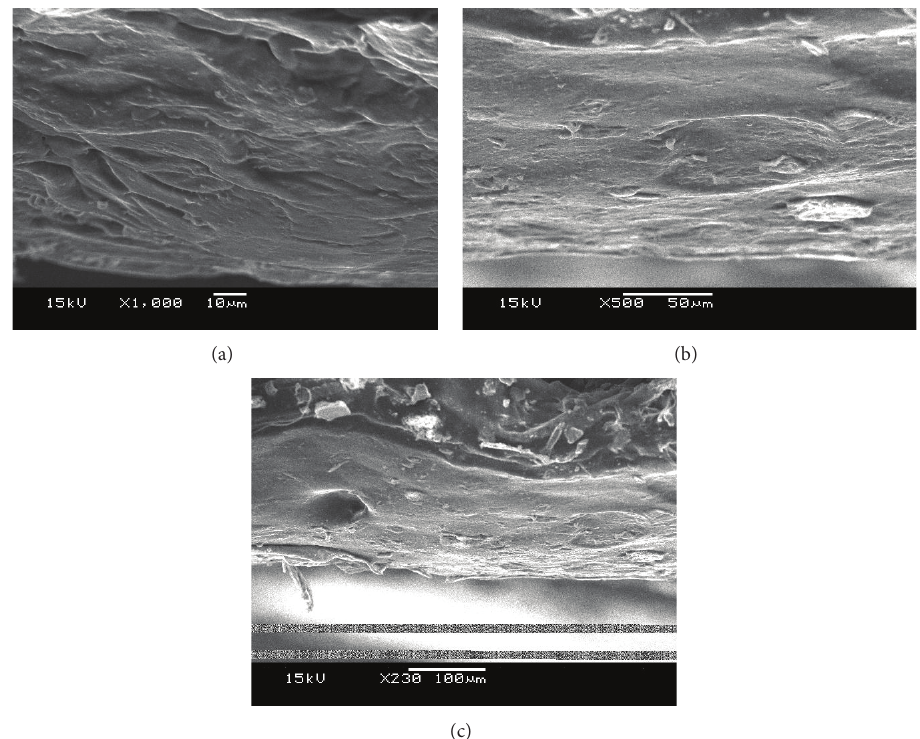
Figure 2: SEM image of the cross-sectional quaternized polysulfone membrane.